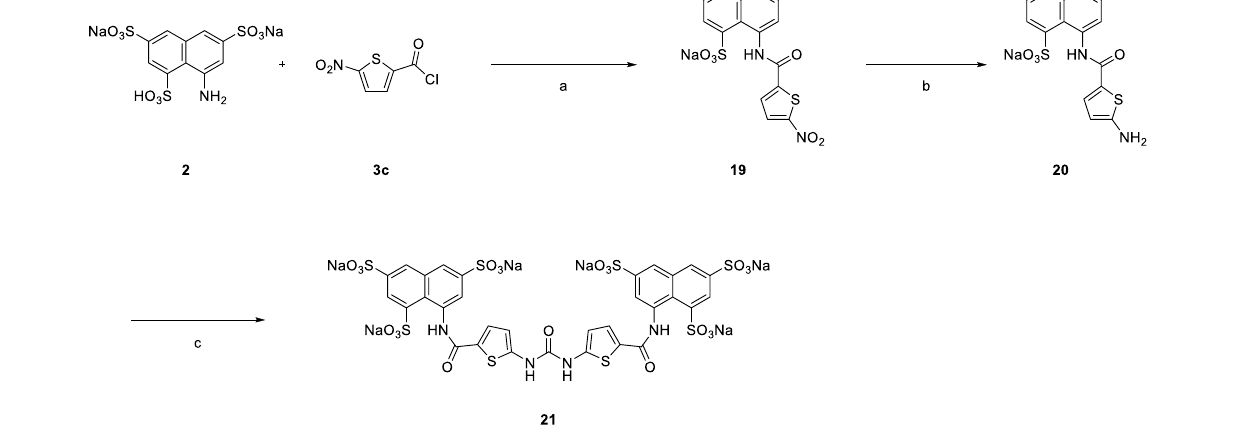
SCHEME 4 | Syntheses of heterocyclic suramin derivative 21 .